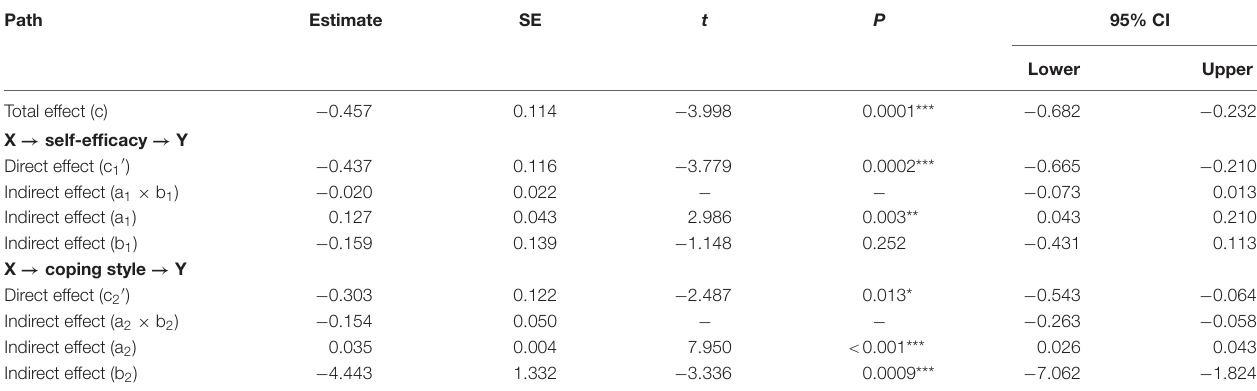
TABLE 2 | Total, direct, and indirect effect of psychological flexibility on vaccine hesitancy through self-efficacy and coping style. Path